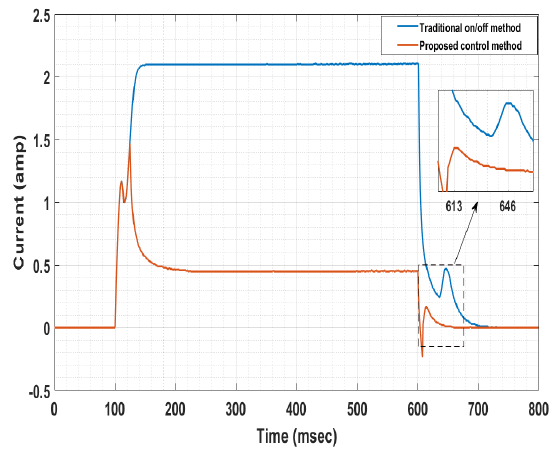
Figure 134. Solenoid current when the solenoid is energized by the traditional on/off method and the proposed control method.